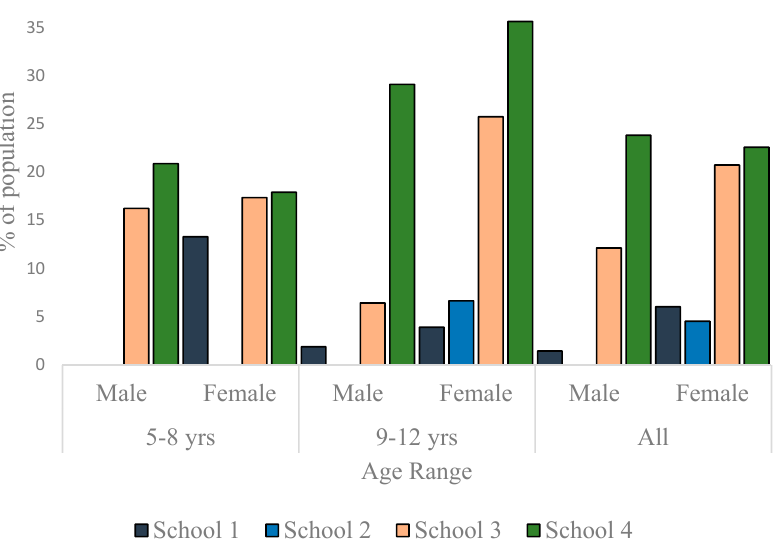
Figure 5. Overweight prevalence among children in the studied schools.